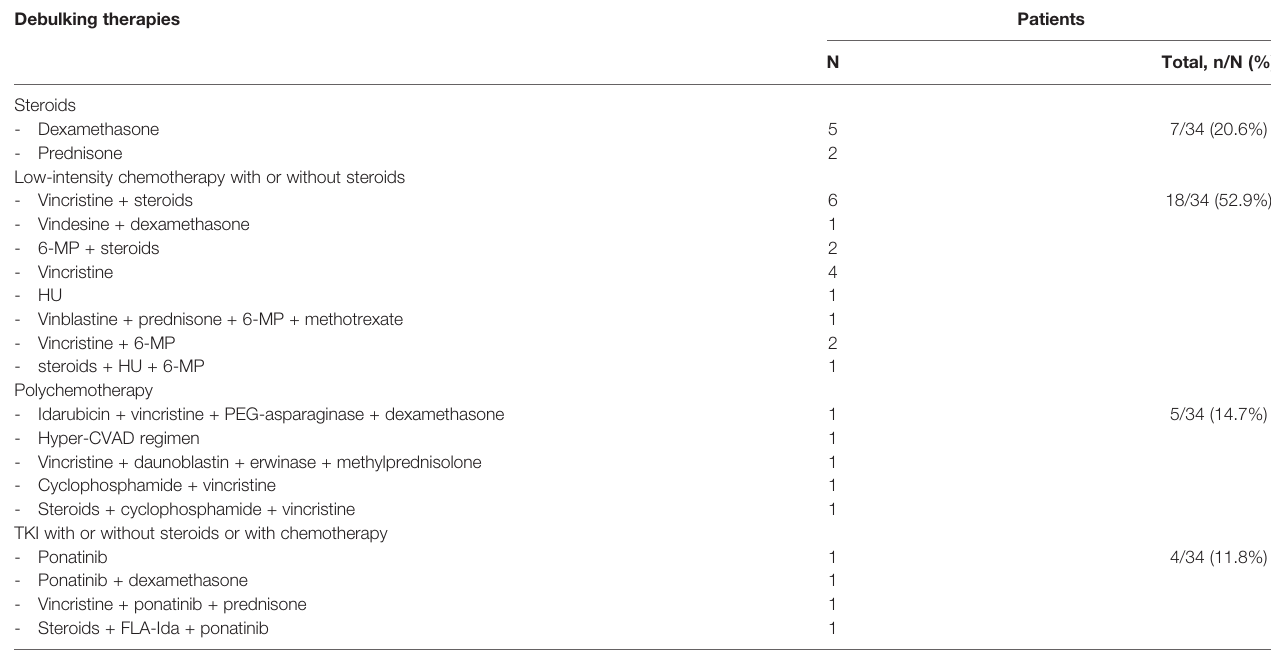
TABLE 2 | Debulking therapies